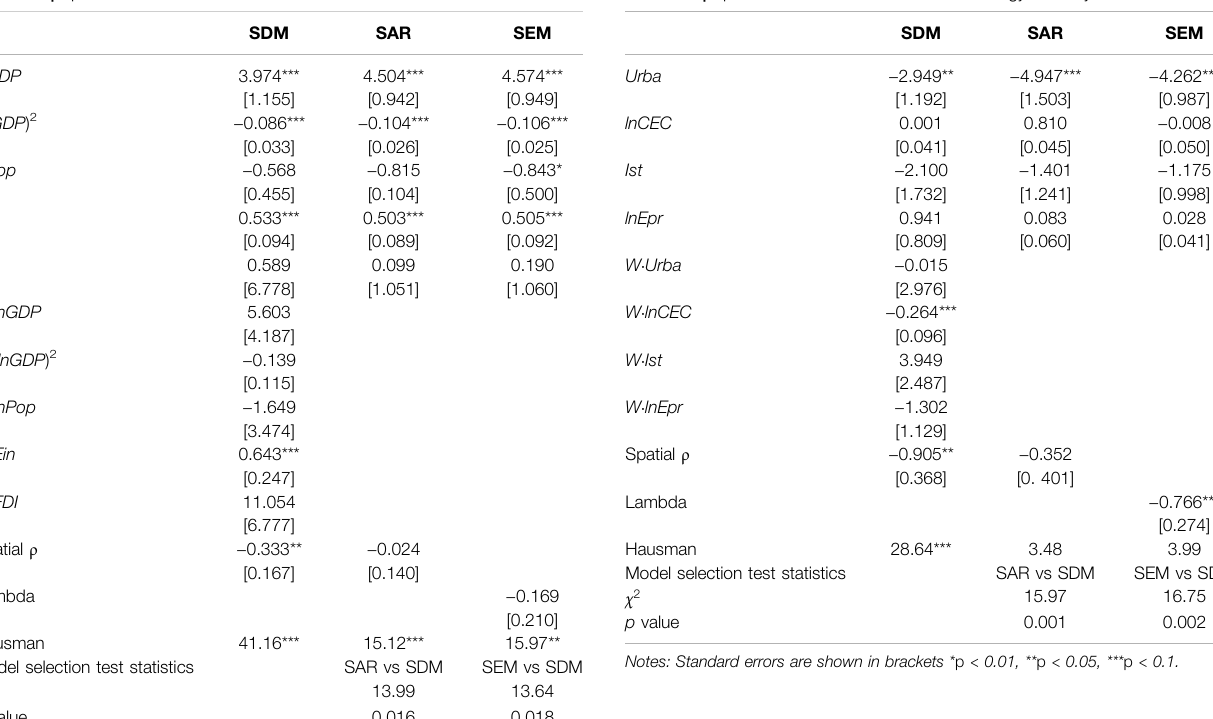
TABLE 6 | Spatial model estimation results in the initial.